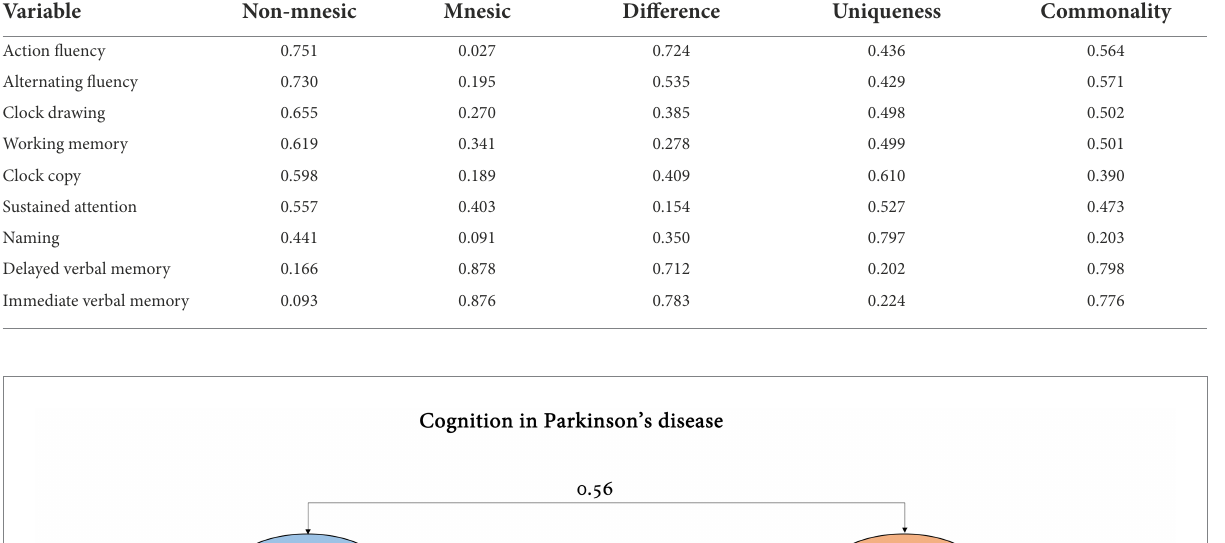
TABLE 3 Factor loadings for non-mesic and mnesic domains of PD-CRS in Colombia. Variable